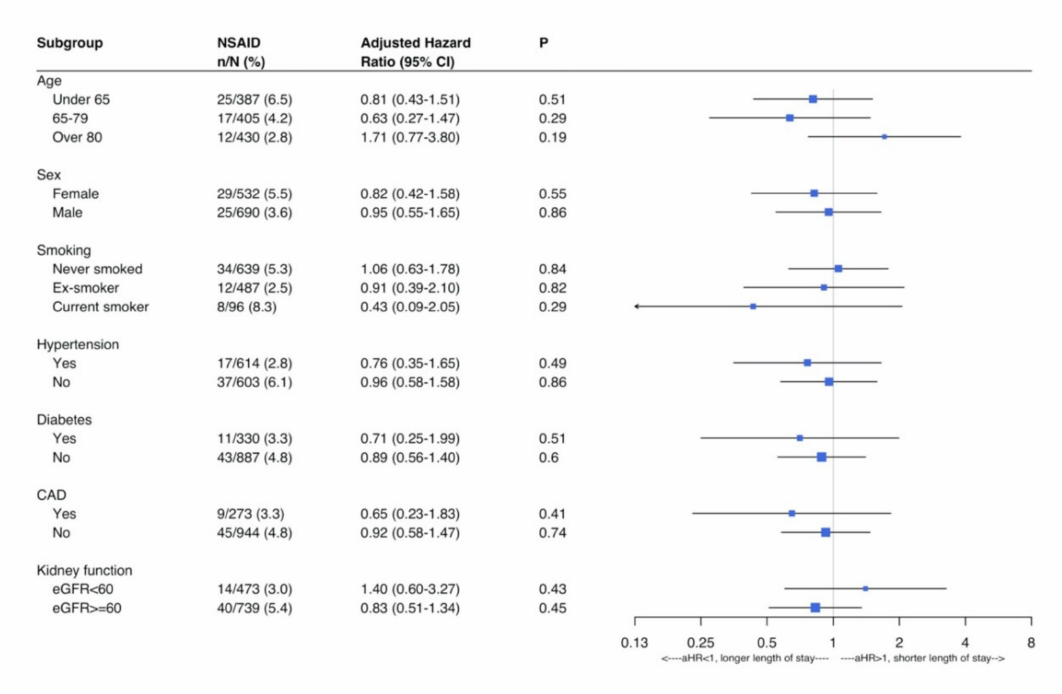
Figure A3. Subgroups: time to discharge, adjusted hazard ratio are presented from the multivariable Cox PH model. Note: multivariable analyses adjusted for age group, sex, smoking status, hypertension, diabetes, CAD, kidney function, and elevated CRP